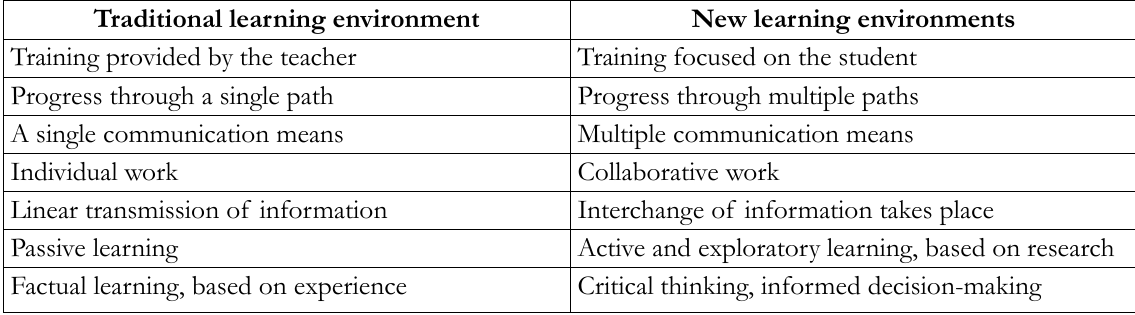
Table 1. Differences between traditional and new learning